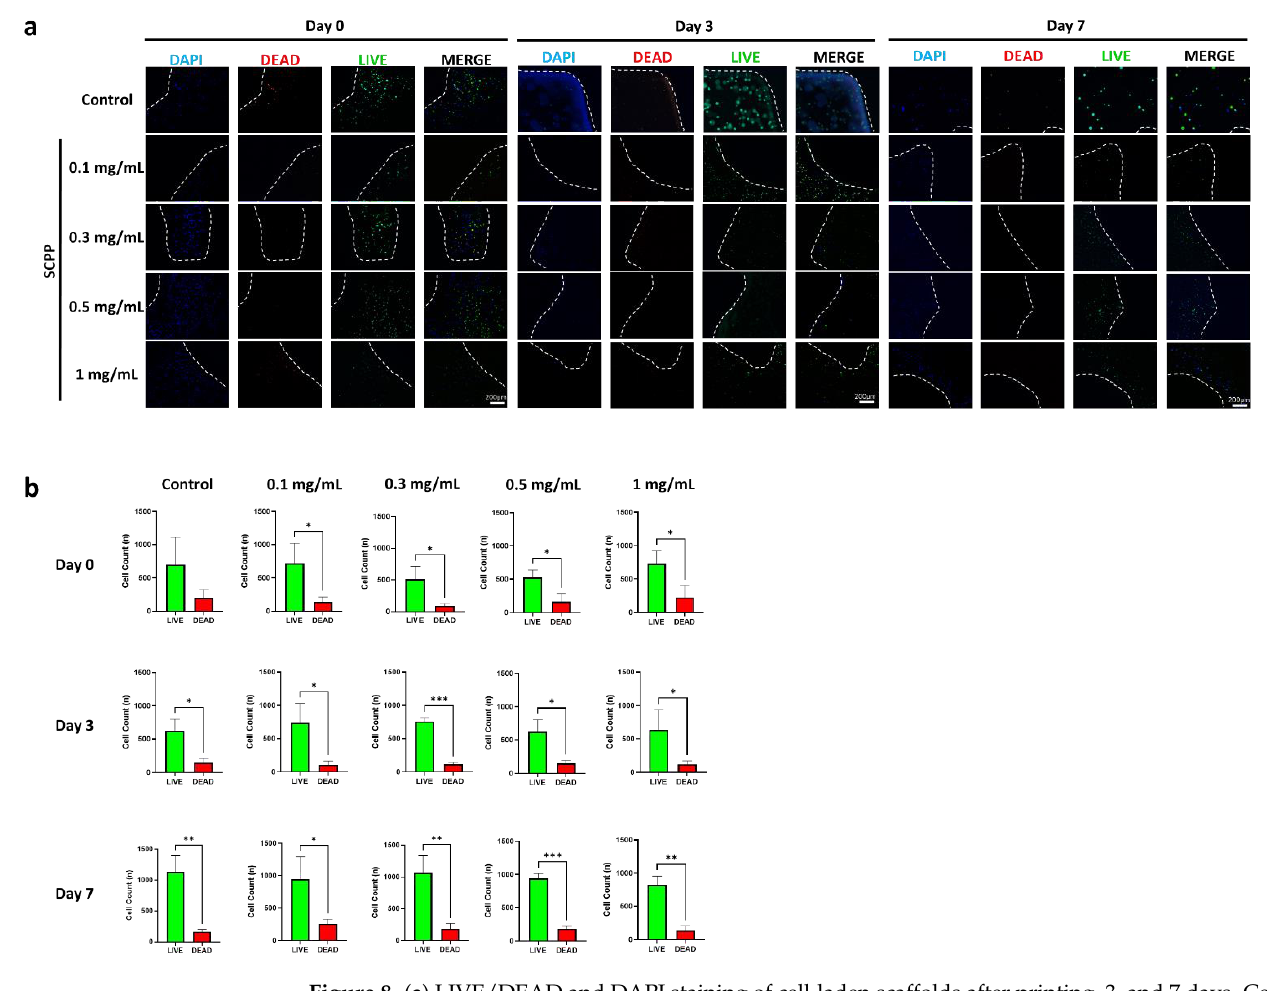
Figure 8. ( a ) LIVE/DEAD and DAPI staining of cell-laden scaffolds after printing, 3, and 7 days. Cells are present throughout the scaffold for up to 7 days. Dashed lines represent the borders of the scaffolds. ( b ) Quantification of LIVE/DEAD fluorescence over 7 days indicates cell growth. The greatest number of dead cells were present on day 0, after printing. * p ≤ 0.05, ** p ≤ 0.01, *** p ≤ 0.001.